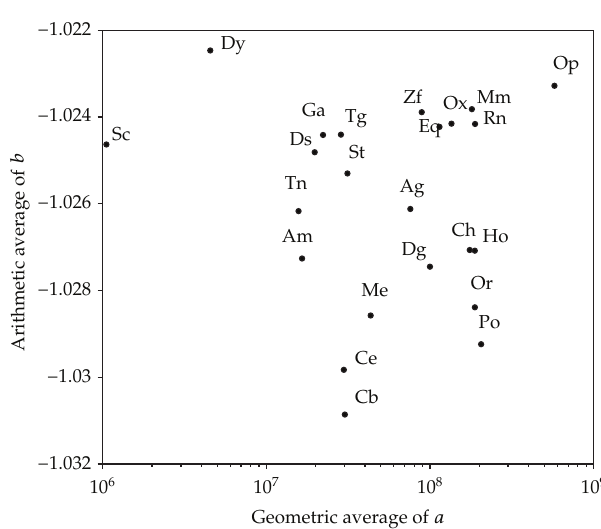
Figure 9: Locus of geometric average of a versus the arithmetic average of b for the twenty-three species.